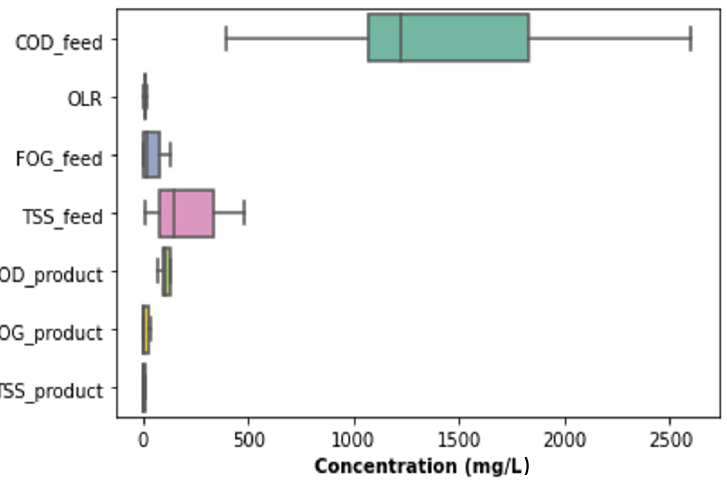
Figure 15. Boxplot of the MBR performance with regard to quantified quality parameters.